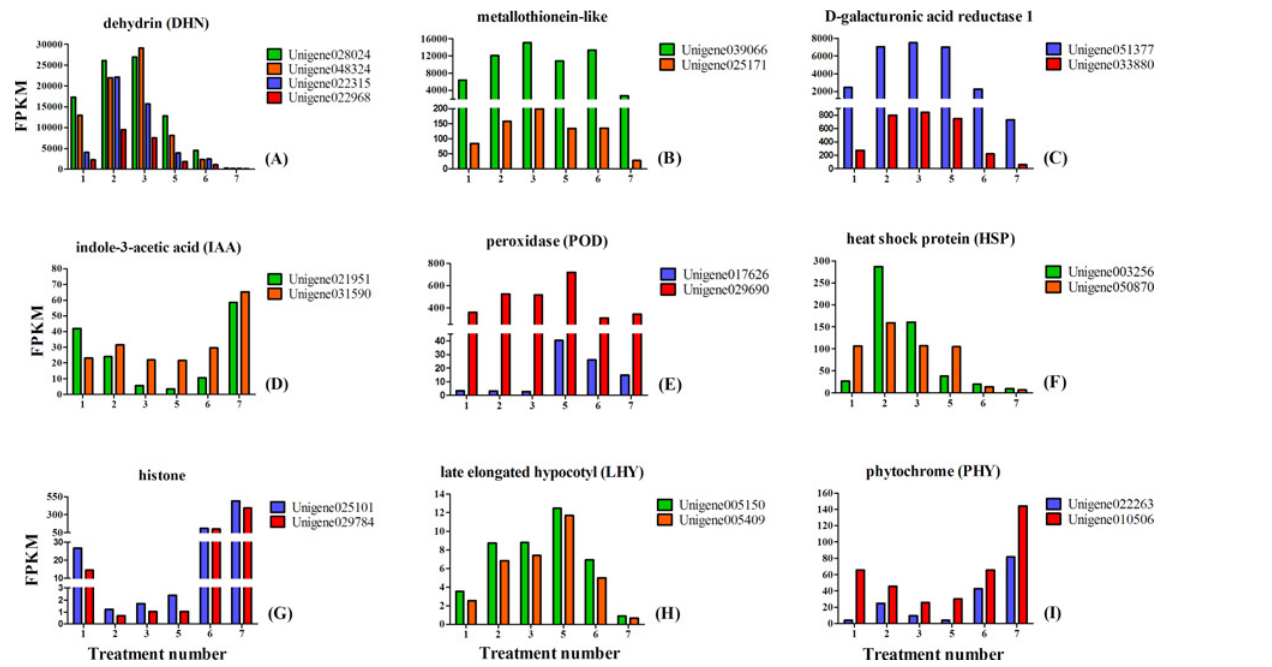
Fig 9. Expression of 20 interested unigenes related to the bud dormancy transition or